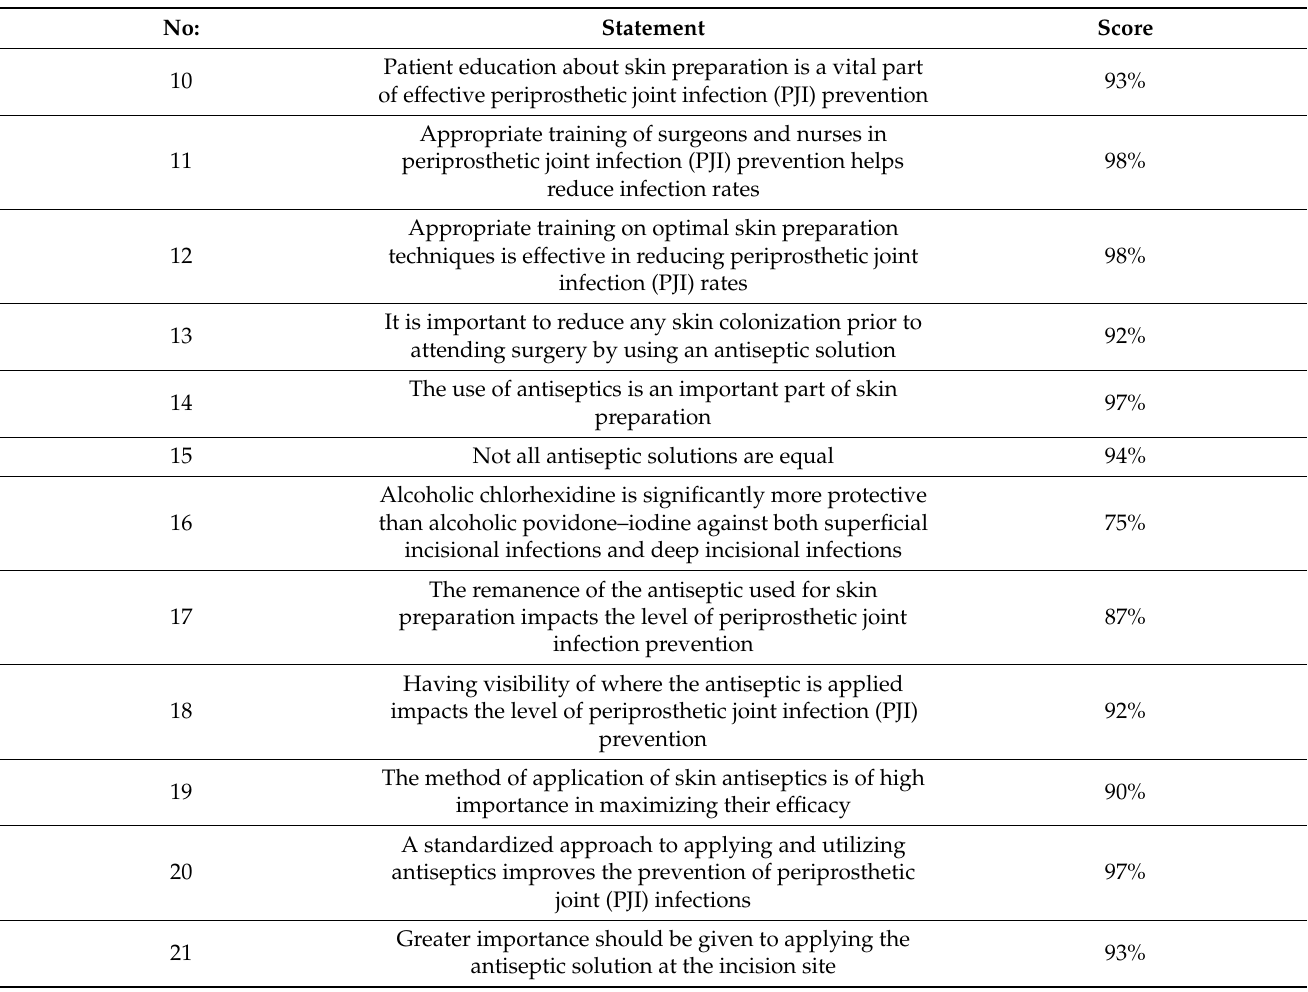
Table 2. Consensus statements and agreement scores on Domain B: importance of skin preparation in preventing PJI.